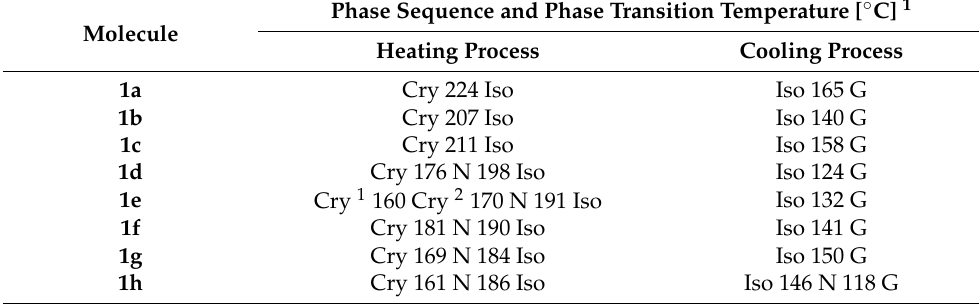
Table 1. The phase transition behavior of the fluorinated tolanecarboxylic acids, 1a – h , during the first heating and cooling process observed by